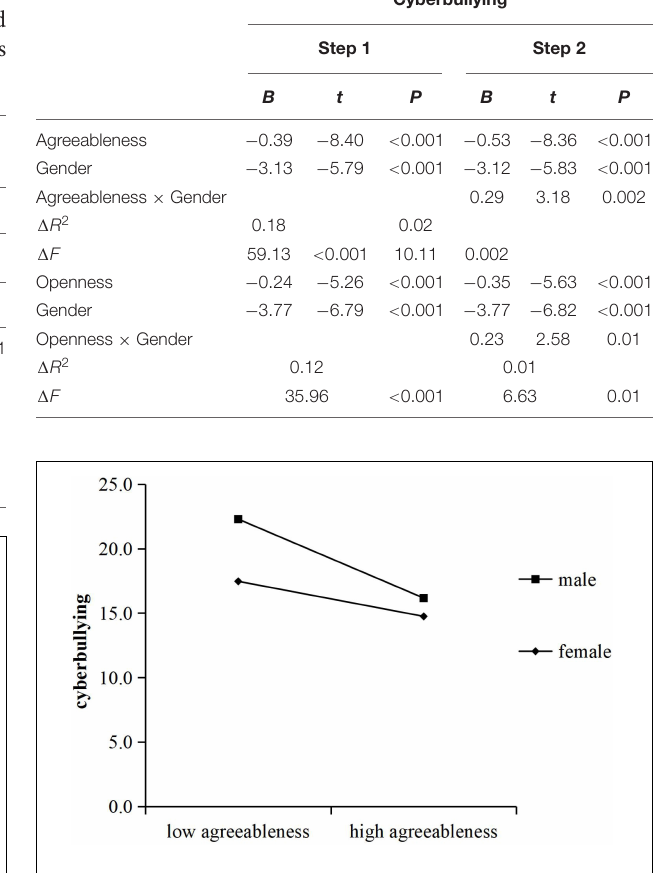
FIGURE 1 | The moderating effect of Internet self-efficacy (ISE) on agreeableness and cyberbullying.